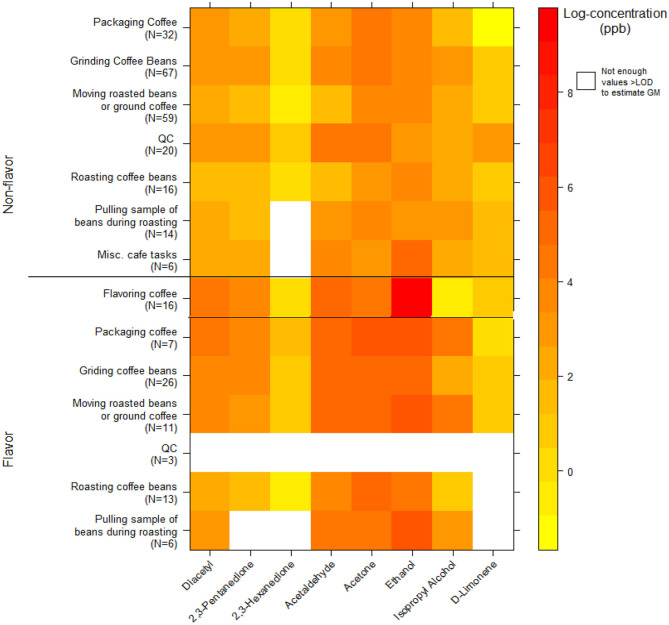
Heatmap of personal instantaneous activity exposures for select VOCs (log-concentration in ppb) using canisters (NMAM 3900).